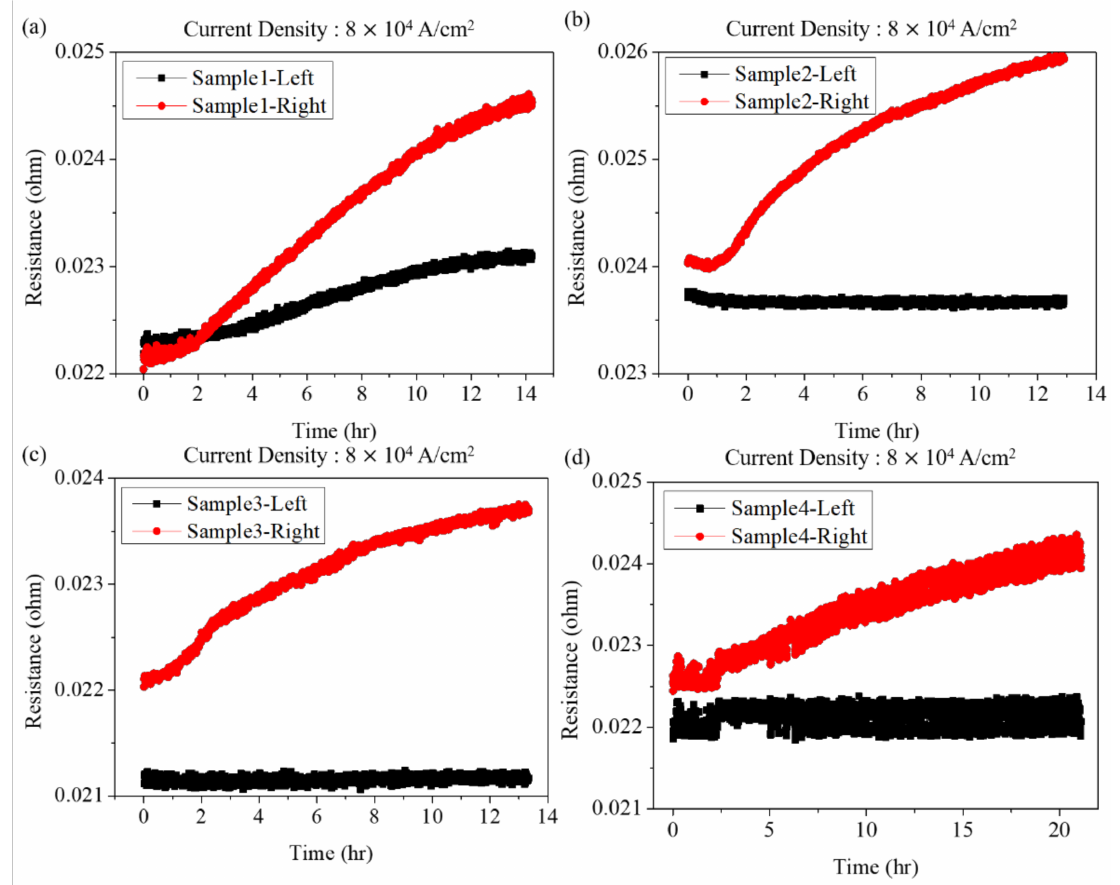
Figure 4. The resistance changes of ( a ) sample-1 ( b ) sample-2 ( c ) sample-3, and ( d ) sample-4 under a high current